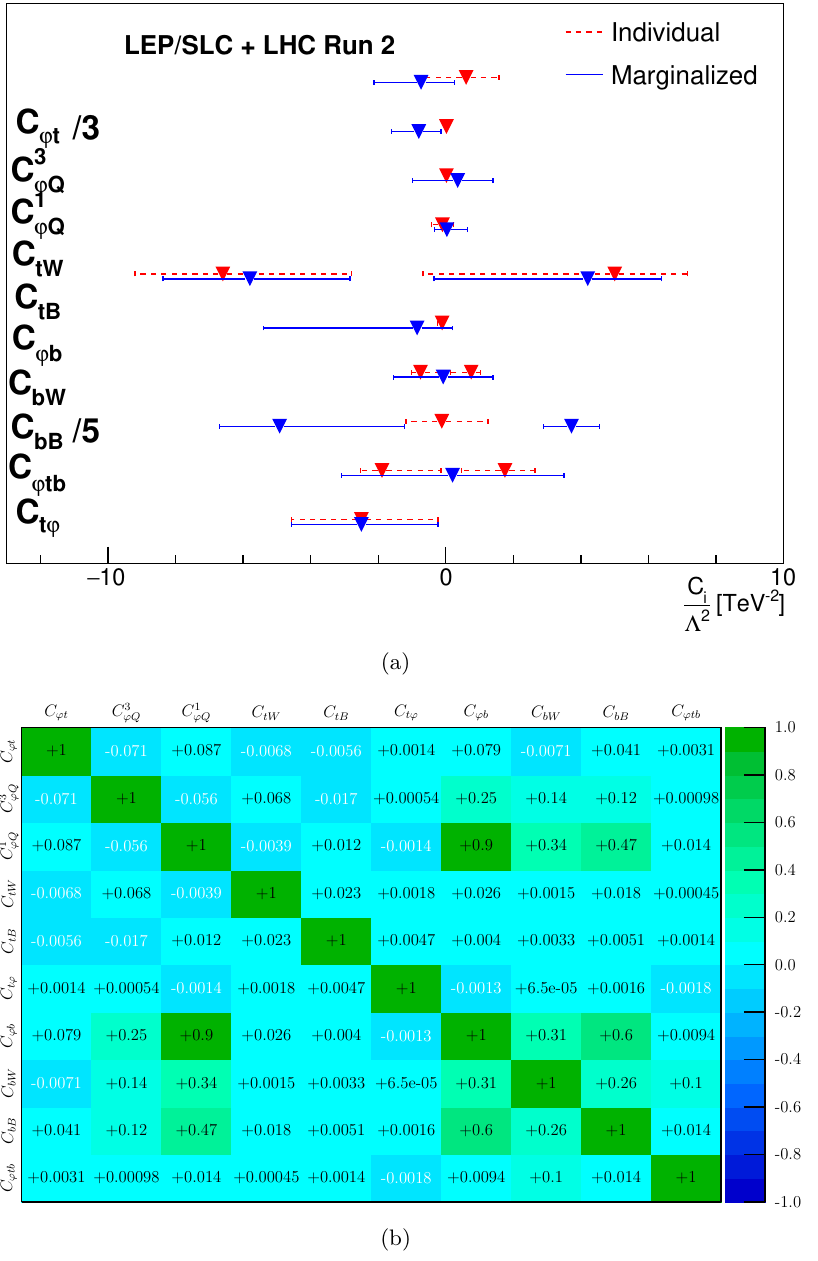
Figure 2 . The 68% probability intervals (upper panel) and correlation matrix (lower panel) for the Wilson coefficients of the ten effective operators that modify the EW couplings of top and bottom quarks derived from a fit of the data included in table 1. The correlation matrix in HEPfit is calculated following ref. [9]. Detailed information about the correlation between the parameters and the complete covariance matrix of the fit are given in appendix C.1. Global (marginalized) limits obtained in the fit are shown as blue bars, the individual limits from single-parameter fit in red. The (local) minimum of the χ 2 are shown as